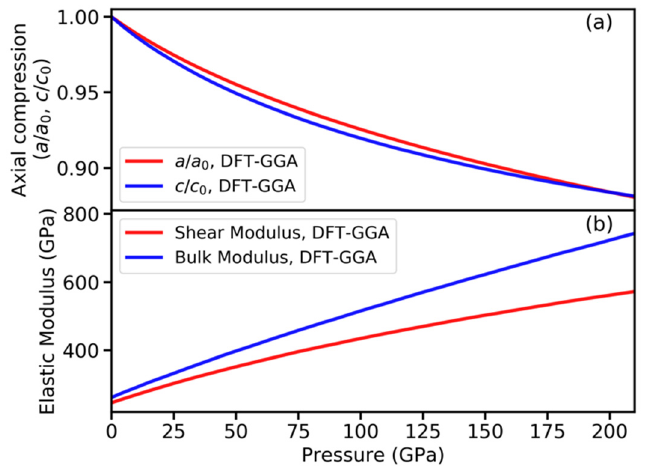
Figure 4. Pressure dependences of ( a ) axial compression of lattice parameters a/a 0 and c/c 0 , and ( b ) bulk and shear moduli for HfB 2 . The density functional theory (DFT) calculations used the generalized gradient approximation (GGA) functional.